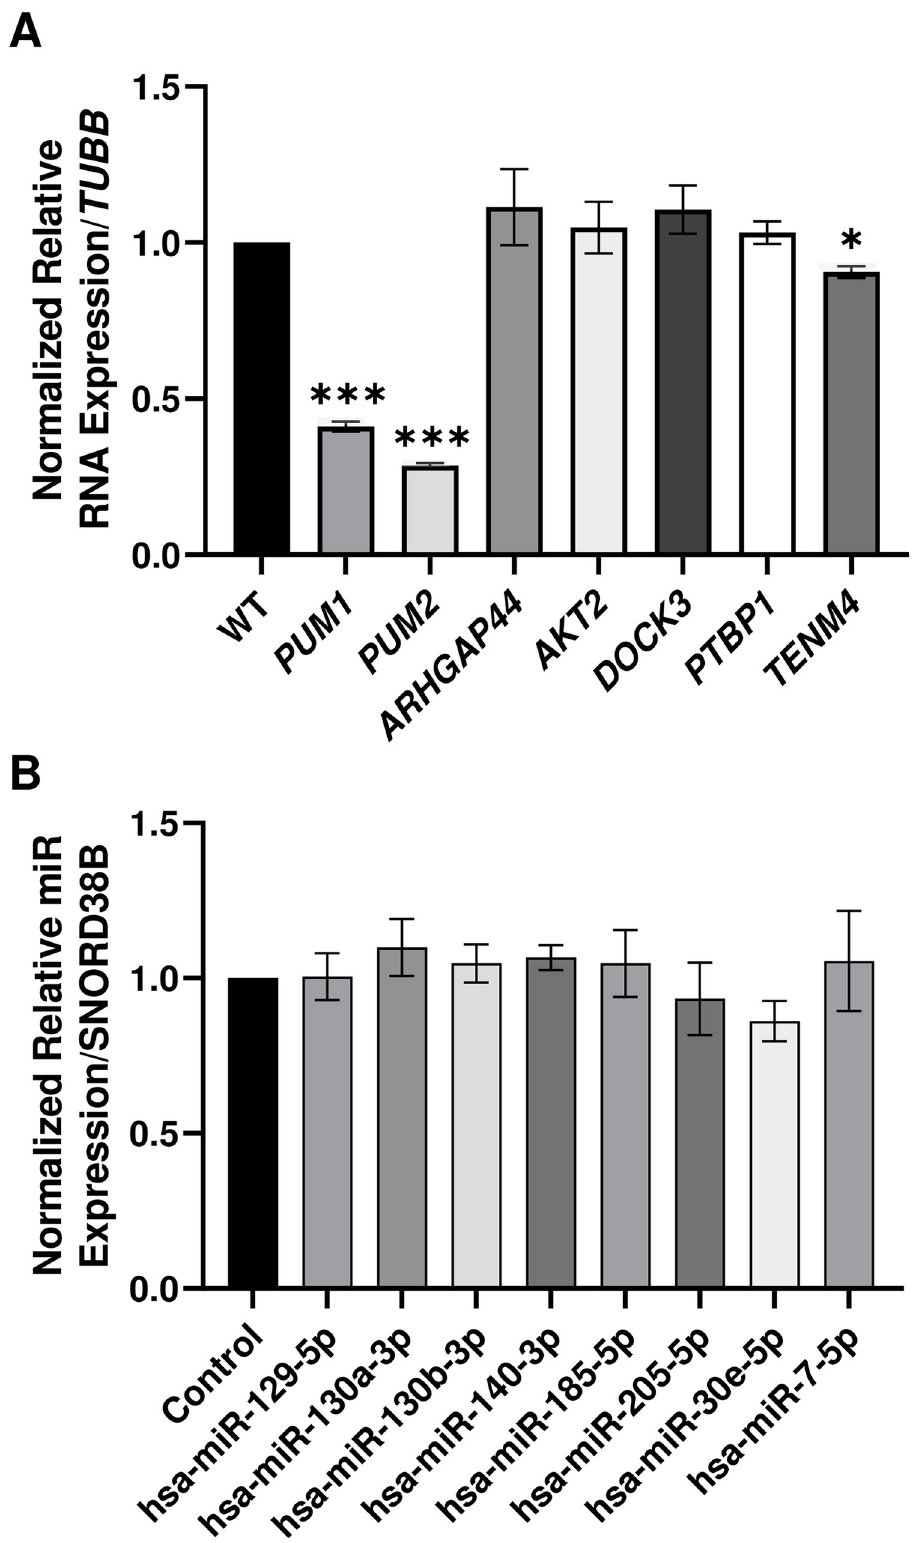
Fig 4. Relative expression of microRNAs and microRNA host genes in SH-SY5Y cells in wild type and PUM knockdown states. (A) Expression of host genes of miRs found in Table 1 that contain canonical PRE motifs in